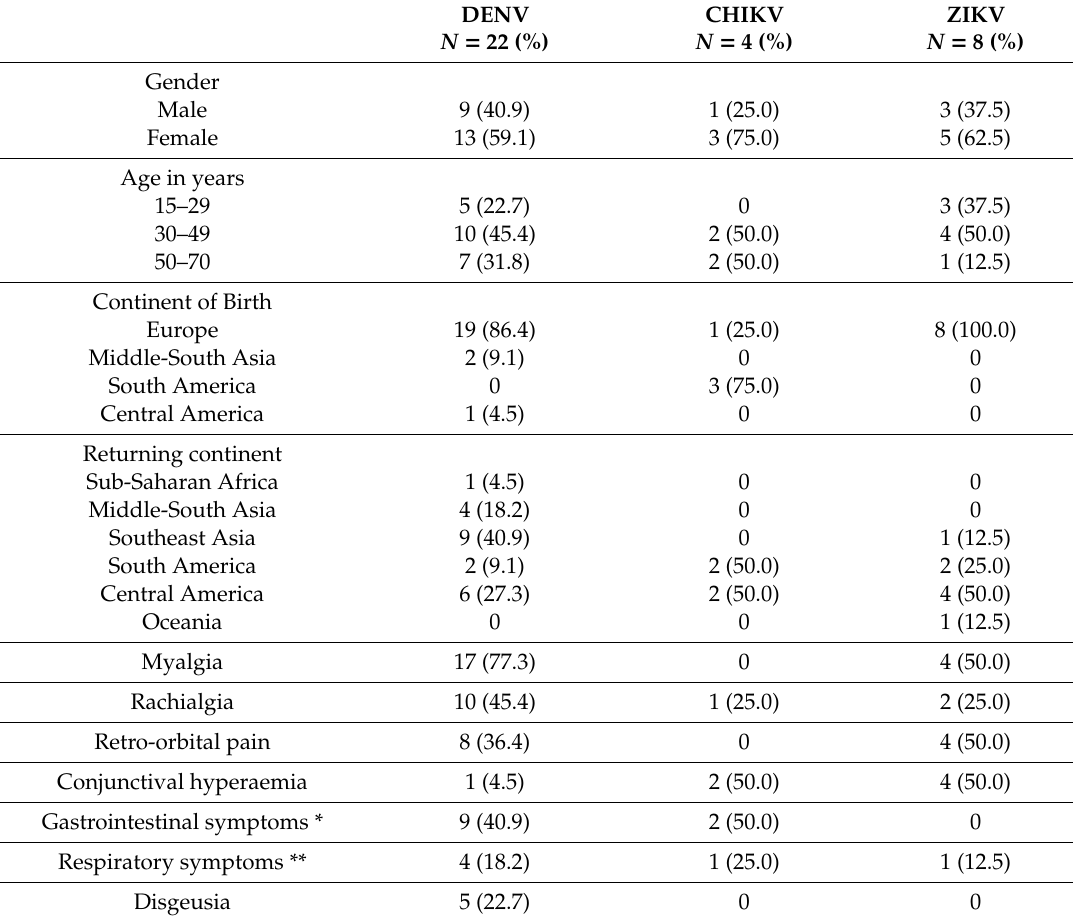
Table 2. Clinical and demographic characteristics of DENV, CHIKV and ZIKV arbovirosis.